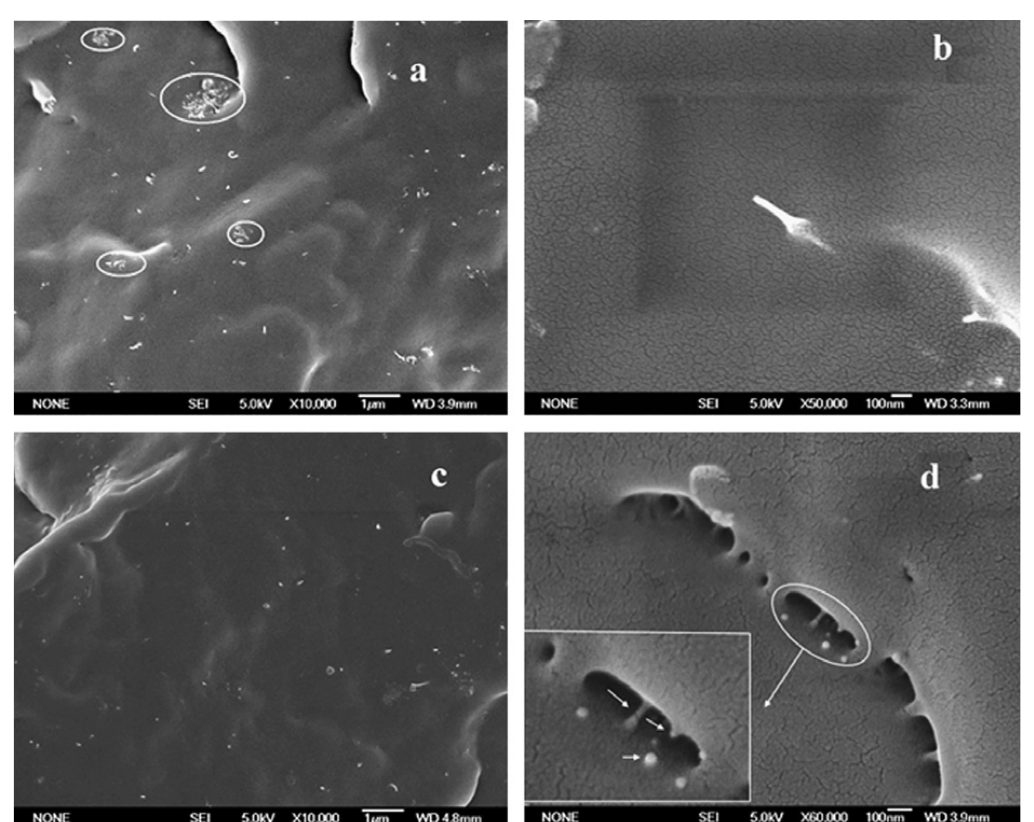
Figure 41. FESEM images of (a and b) PP/1 wt % raw MWCNTs; (c and d) PP/1 wt % 3- MPTS functionalized MWCNTs composites. Reproduced with permission from ref.